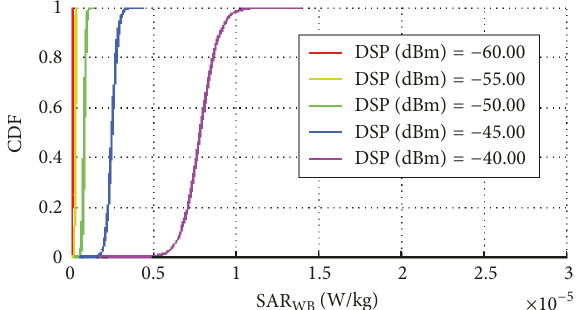
Figure25:CDFsofSAR inducedbythedownlink(5planewaves) WB at 1940MHz for various values of